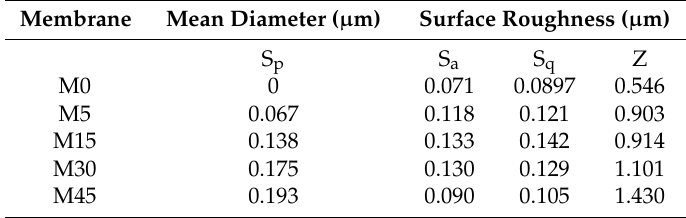
Table 1. Mean diameter and surface roughness of the metalized membranes with different sputtering times.